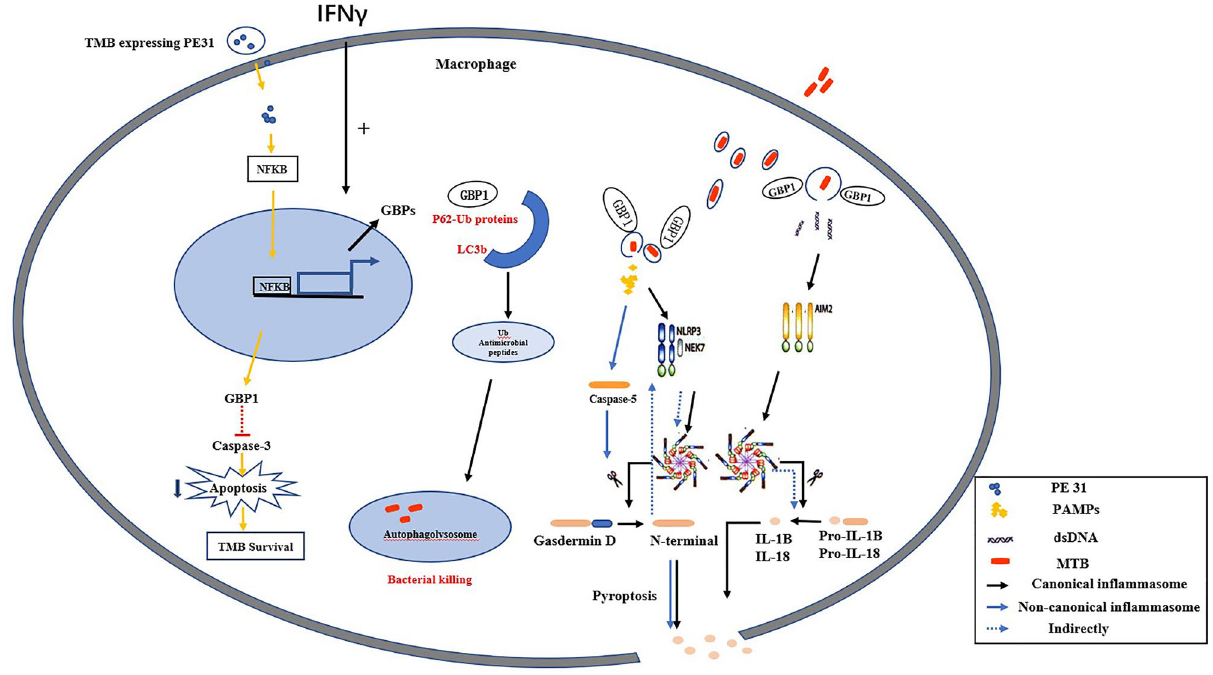
Figure 5. Potential mechanism of high expression of GBP1 associated with TB in